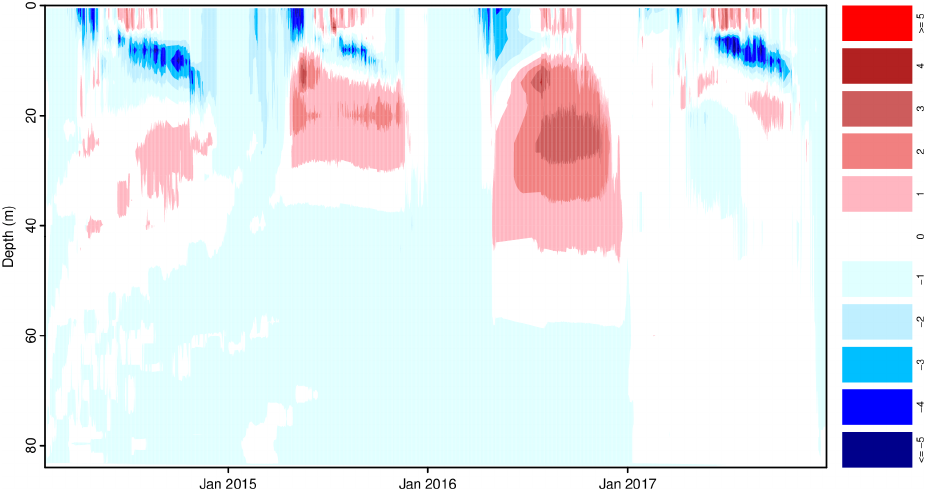
Figure 9. Contour plot of differences between simulated and observed water temperatures of lake